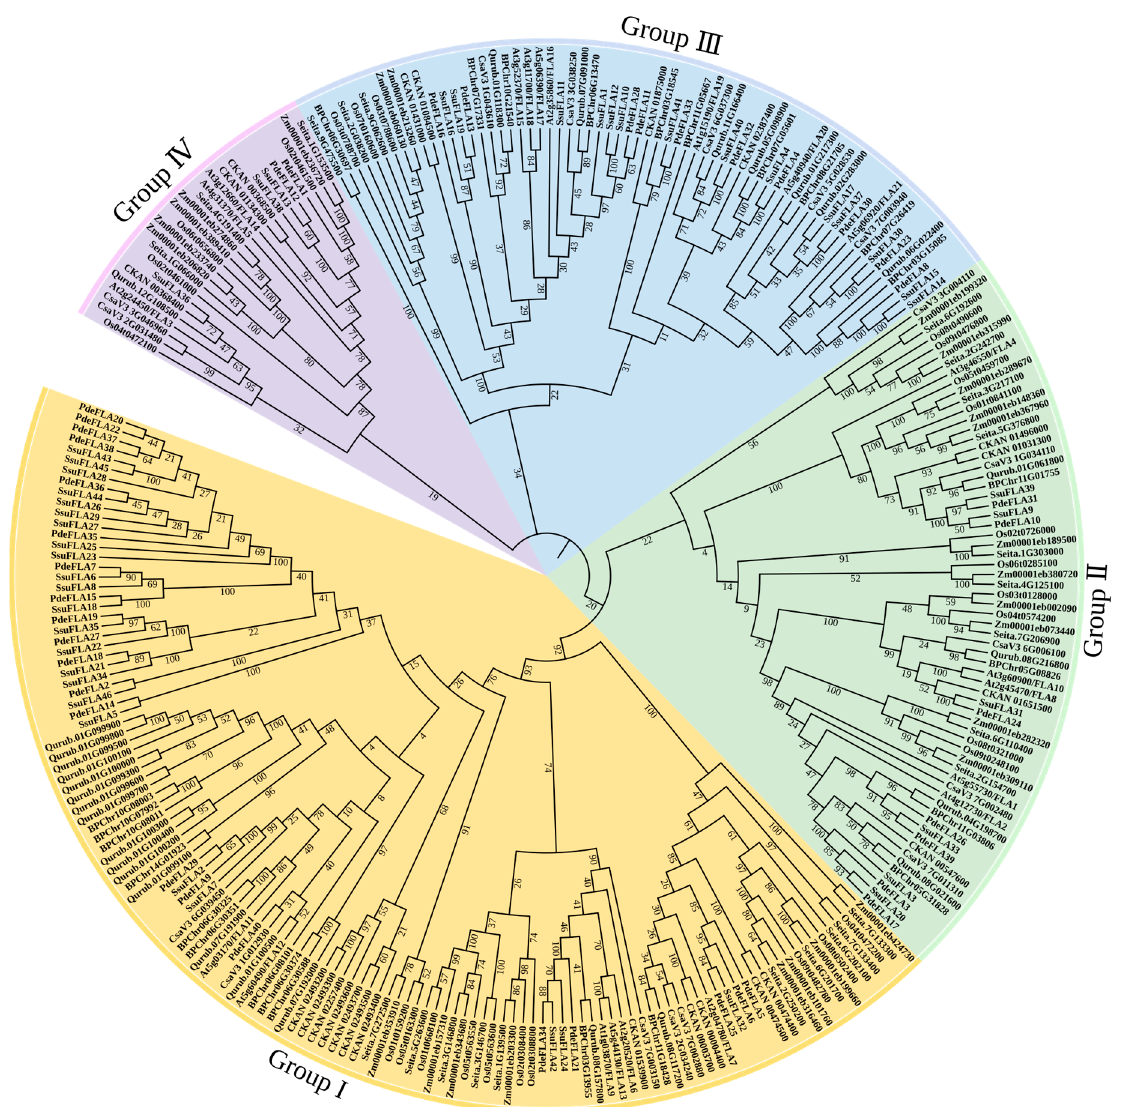
Figure 4. The phylogenetic tree of FLA proteins from P. deltoides , S. suchowensis , Corylus avellana L., Quercus rubra L., Cinnamomum kanehirae , Setaria italica , Zea mays L., Cucumis sativus L., Oryza sativa L., and Arabidopsis thaliana . A total of 277 FLA proteins were analyzed using ClustalX 2.1, and the Neighbor-Joining tree was constructed using MEGA 11 software. The bootstrap value was 1000 replicates. The FLA proteins were clustered into four distinct groups (I–IV), represented by different colors.